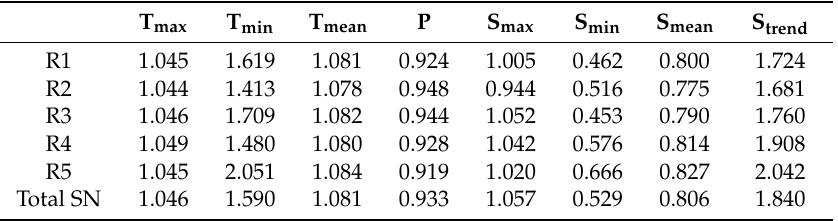
Table 3. Ratio between the average absolute values of the target variables under both RCPs throughout the future period (RCP 8.5/RCP 4.5). T max T min T mean P S max S min S mean S